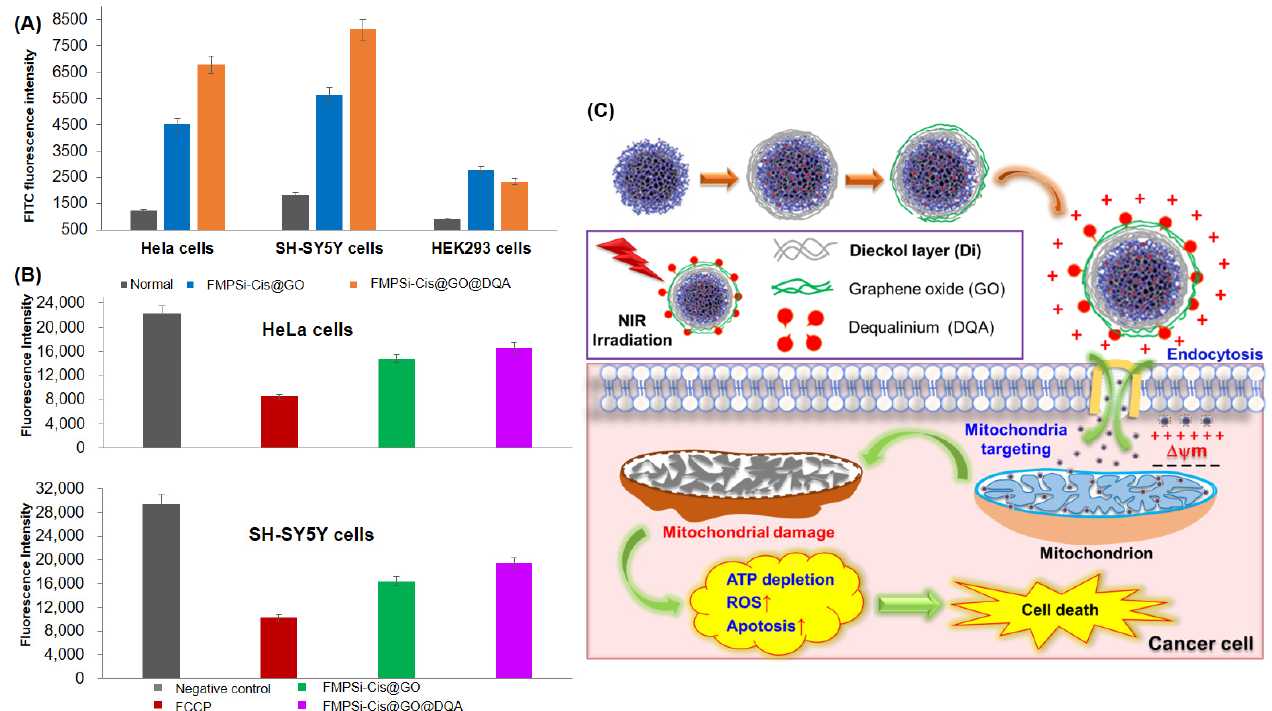
Figure 4. The rationale for mitochondria-targeting of multifunctional mesoporous silicon nanopar- ticle system to assess Δψ m. ( A ) FITC fluorescence absorption intensities of isolated mitochondria measured from HeLa, SH-SY5Y, and HEK293 cells without and with the indicated treatments; ( B ) Mitochondrial membrane potential of HeLa and SH-SY5Y cells after treatment with FMPSi-Cis@GO and FMPSi-Cis@GO@DQA for a short time of 24 h incubation. PBS treatment was the negative (control) group; FCCP treatment was a positive control. Δψ m was measured by fluo- rescence intensity after cells were stained with TMRE. Data are represented as the mean ± SD ( n = 3); and ( C ) Schematic illustration of specific mitochondrion targeting and therapeutic effects of multifunctional mesoporous silicon nanoparticle system.